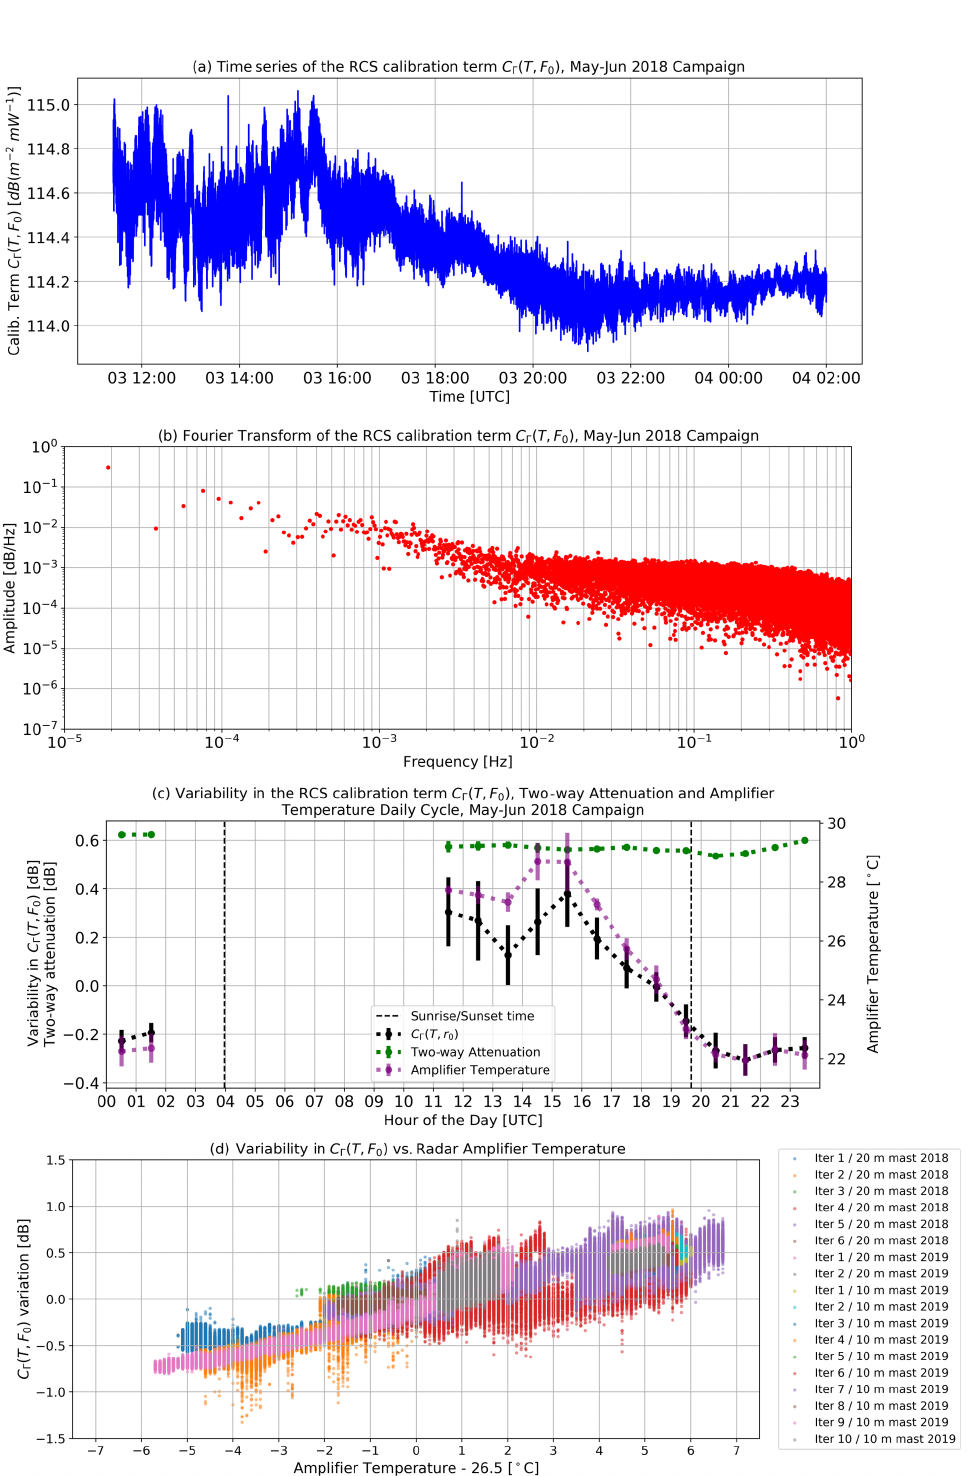
Figure 6. Calibration variability study. Samples from iteration 5 of the 2018 calibration campaign. (a) Time series of the RCS calibration term retrieval. (b) Fourier transform of the RCS calibration term after subtracting the mean value. (c) Calibration variability daily cycle, amplifier temperature and two-way attenuation. Attenuation error bars are too small to be seen at this scale. (d) Relative changes in C (cid:48) (T,F 0 ) versus amplifier temperature plotted using all samples from the 2018 and 2019